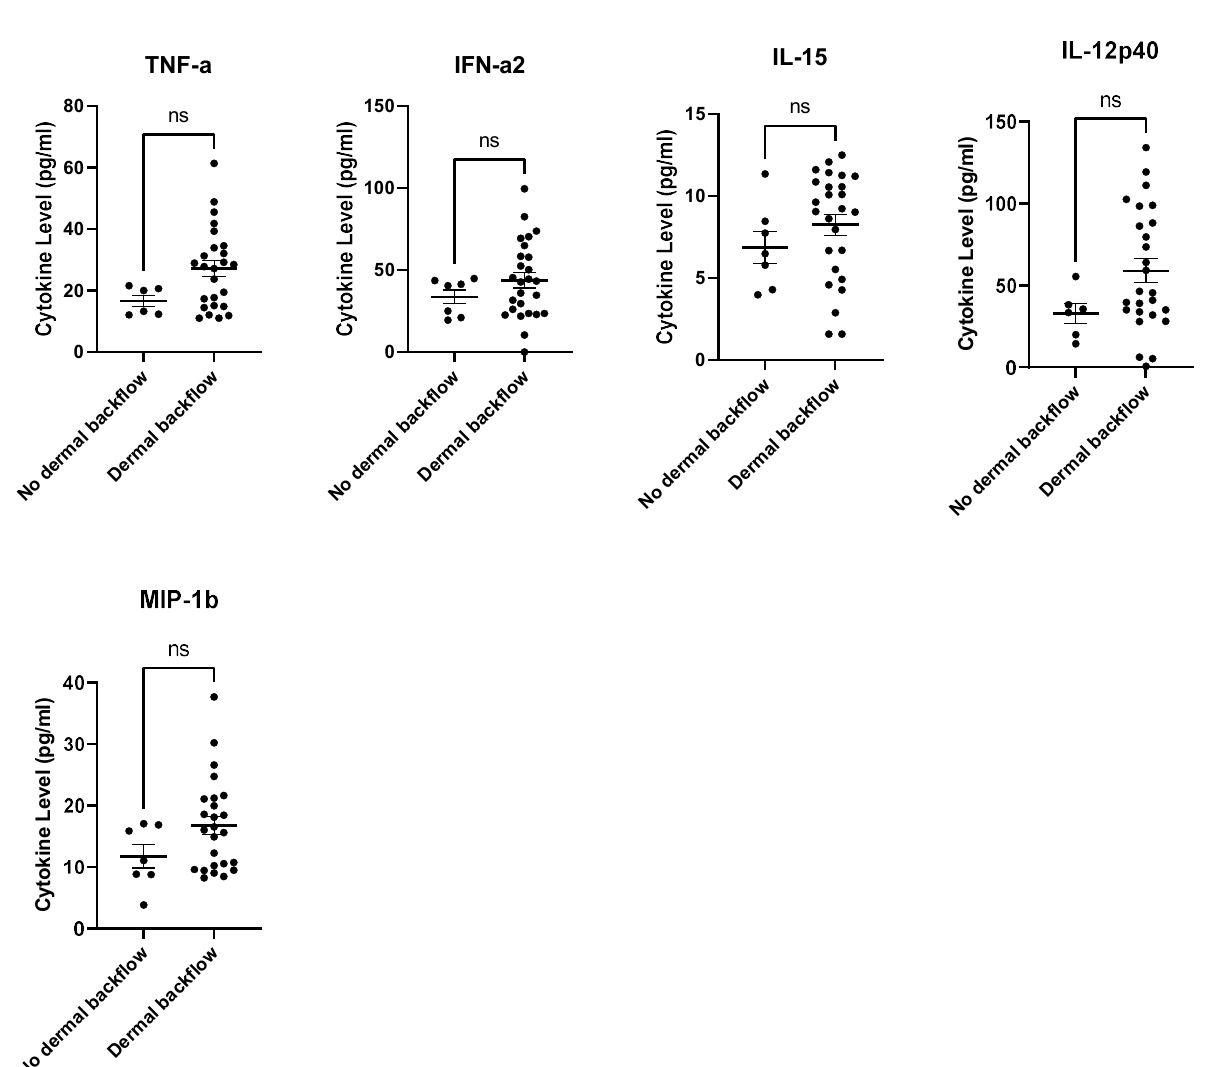
Figure 6. IFN- α 2, IL-12p40, IL-15, MIP-1 β , and TNF- α levels trended higher at 12-months post-RT in subjects with dermal backflow. ( p -values = 0.2463, 0.1071, 0.2119, 0.1230, 0.0962, respectively). ns = p > 0.05.